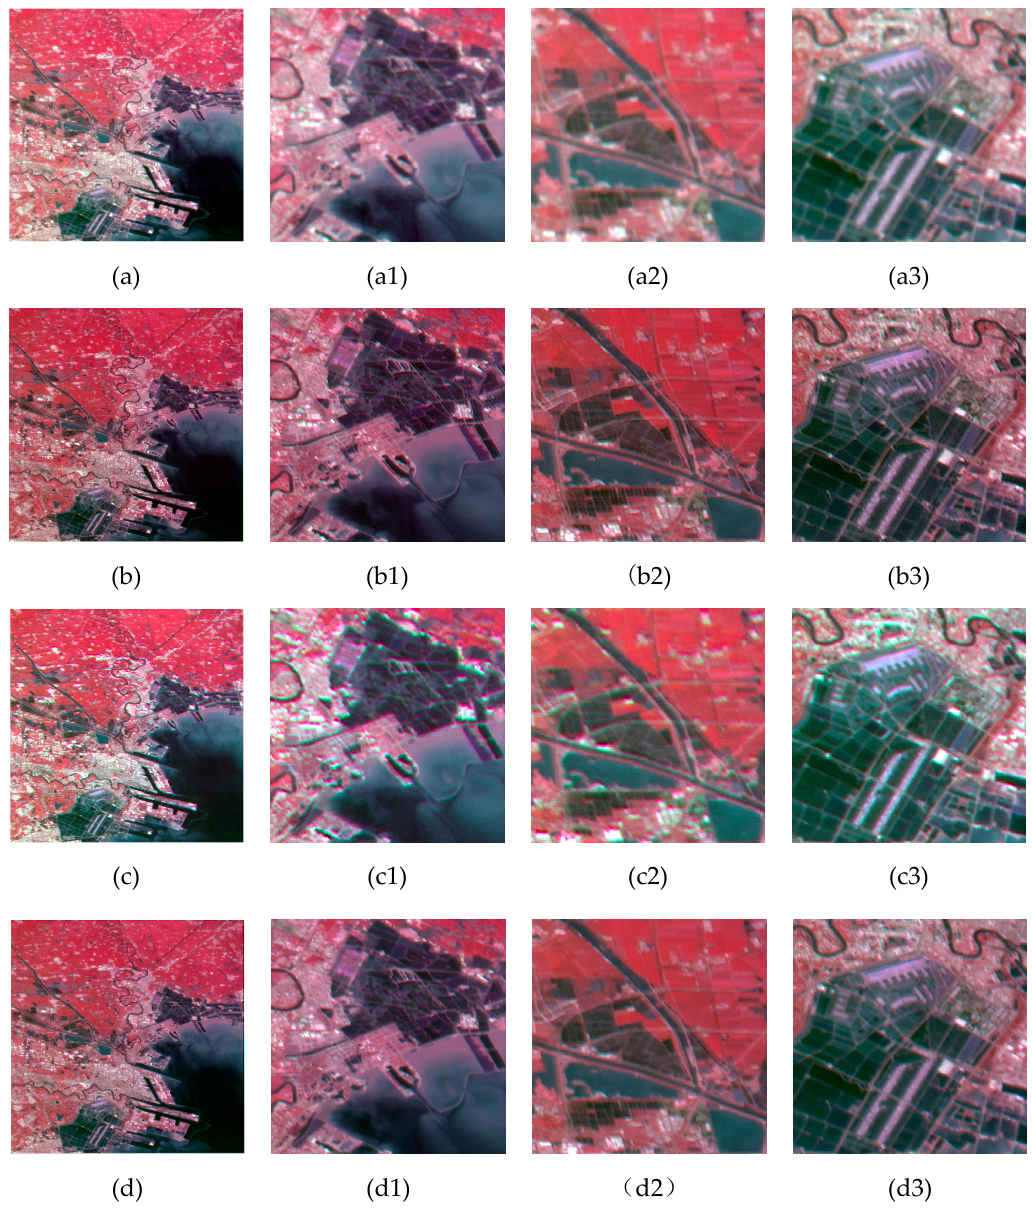
Figure 4. Results of the super-resolution reconstruction (SRR) for Experiment 1 using the (a) bilinear interpolation (BI), (b) iterative back projection (IBP), (c) projection onto convex sets (POCS), and (d) mixed sparse representation non-convex high-order total variation (MSR-NCHOTV) methods. Panels with the suffixes 1, 2, and 3 show local detail magnifications area of the corresponding panel in the left column. Table 2. Evaluation results for image sharpness.